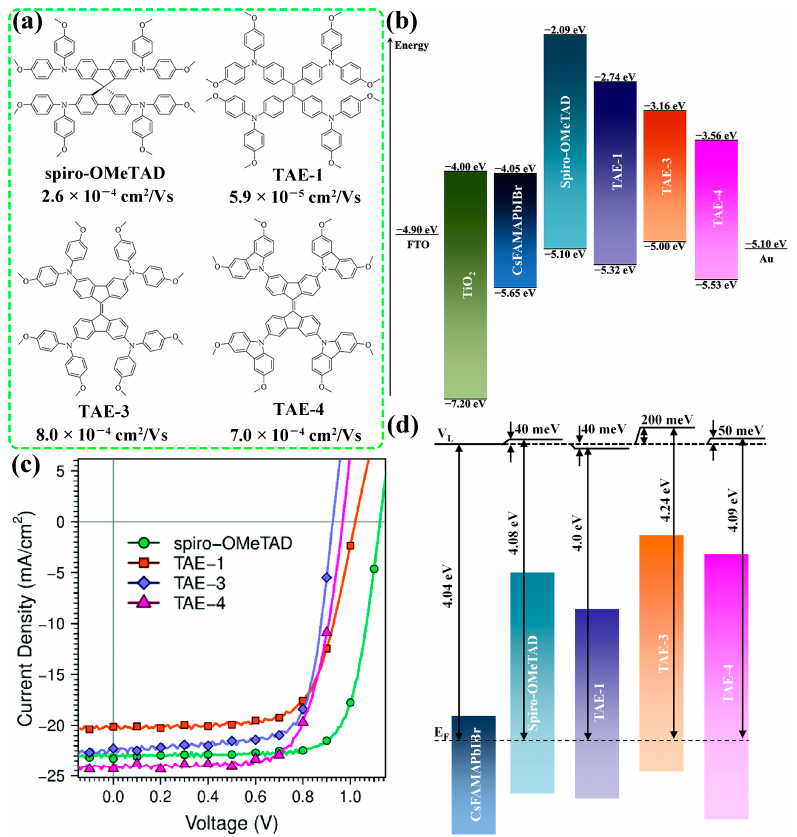
Figure 2. Molecular structures and hole mobilities ( a ), energy levels obtained from CV measure- ments ( b ), and current-voltage ( J - V ) curves ( c ) of spiro-OMeTAD and TAE HTMs. ( d ) V L positions of different perovskite/HTM stacks. Adapted with permission from Ref. [34]. Copyright 2019 The Royal Society of Chemistry.